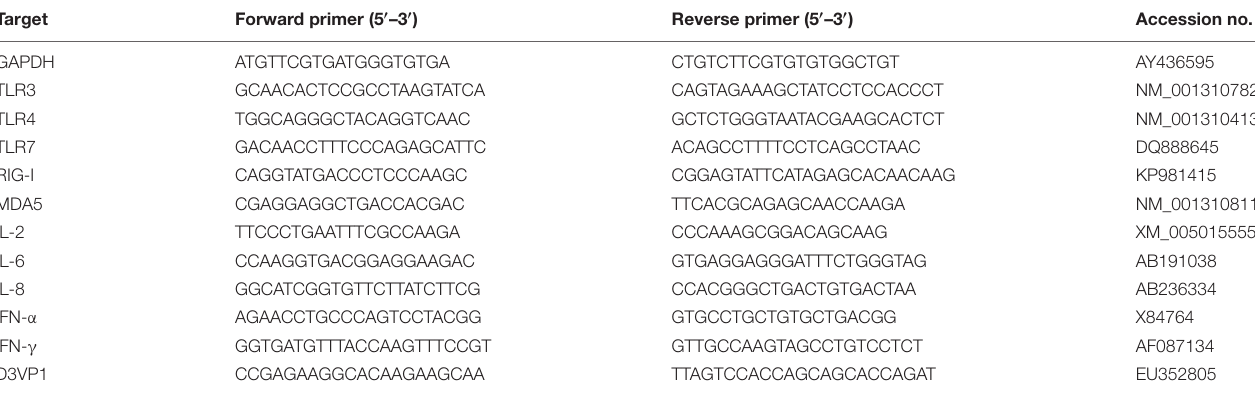
TABLE 1 | Primers used in real-time quantitative RT-PCR assay.